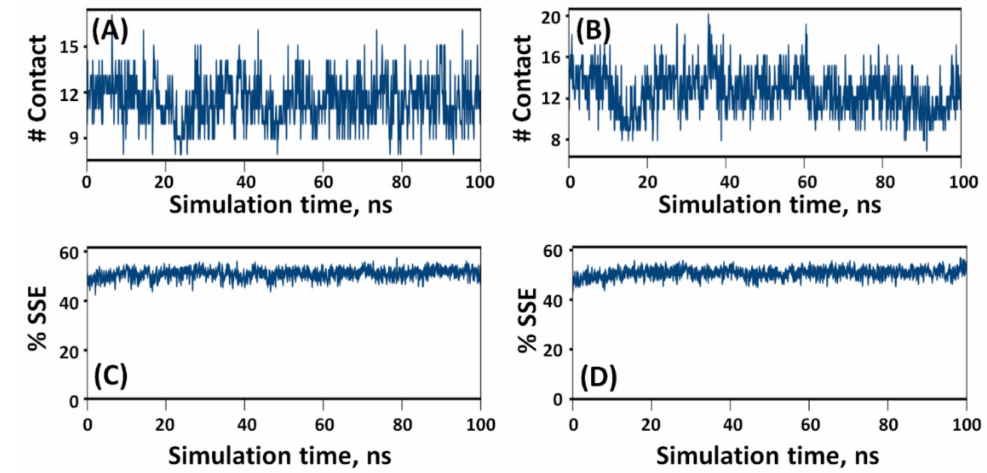
Figure 6. Variation in the number of contacts between NDM-1 and risedronate ( A ) and methotrexate ( B ). Variation in the secondary structure elements (SSEs) of NDM-1 in the presence of ( C ) risedronate and ( D )